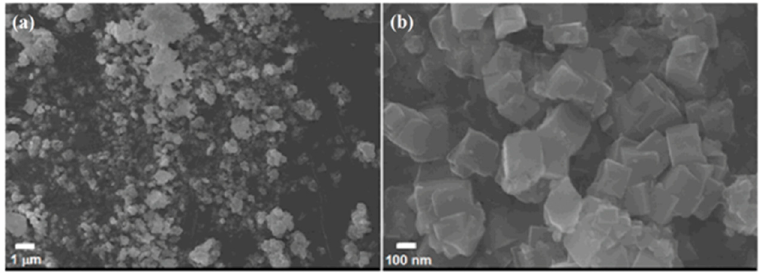
Figure 2. The SEM images of TiO 2 /SrTiO 3 composite at low ( a ) and high ( b ) resolutions.